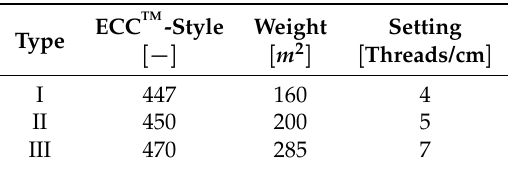
Table 1. Selected properties of ECC-style fabric reinforcements with T ENAX R (cid:13) HTA 40 3K (200 tex) yarns.